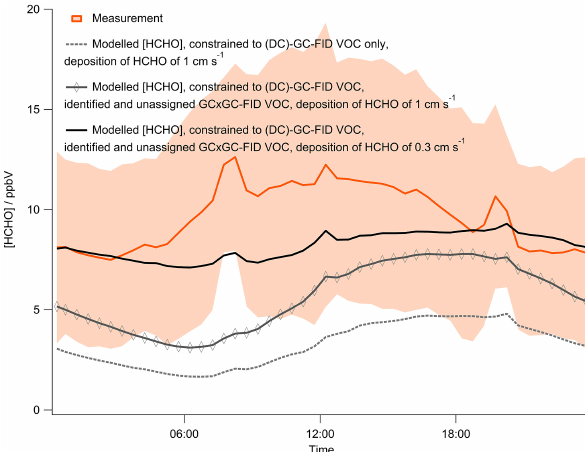
Figure 7. Average diurnal profile of the observed HCHO and mod- elled HCHO for different model scenarios (see text for further de- tails). The shading represents the 1 σ variability of the measure- ments, with each data point representing 30min averaged